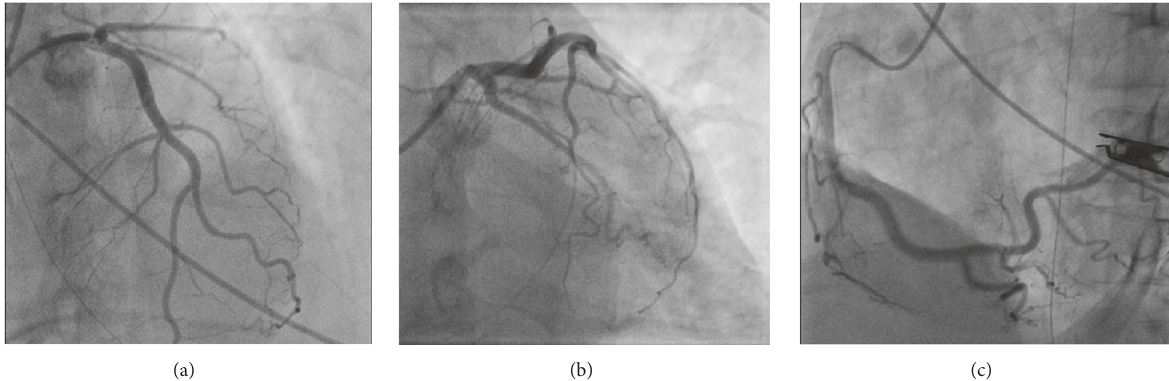
Figure 2: Coronary angiogram showing minor coronary artery disease without culprit lesions. (a) Left anterior descending artery, (b) left circumflex artery, and (c) right coronary